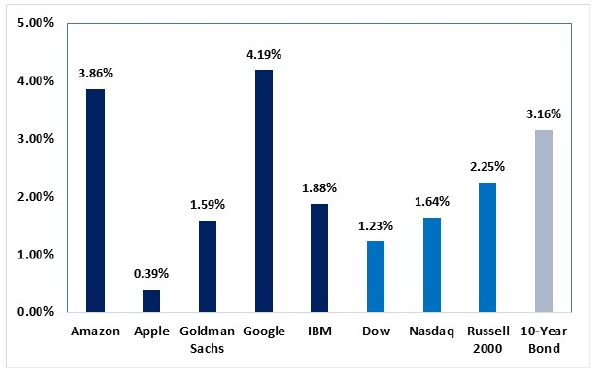
Figure 1. Average weekly returns resulting from the suggested trading strategy.